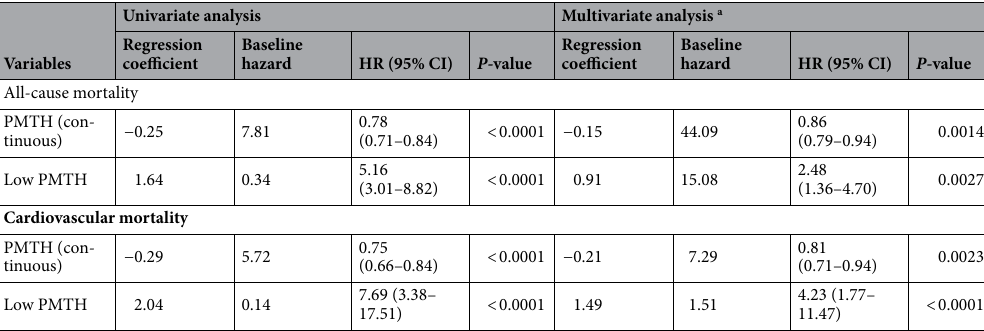
Table 3. Cox proportional hazards analysis of the psoas muscle thickness per height for prediction of all- cause and cardiovascular mortality. HR hazard ratio, CI confidence interval, PMTH psoas muscle thickness per height. a Adjusted for sex, age, history of cardiovascular disease, simplified creatinine index, geriatric nutritional risk index, and log C-reactive protein concentration, which were found to be significant in the univariate analysis.